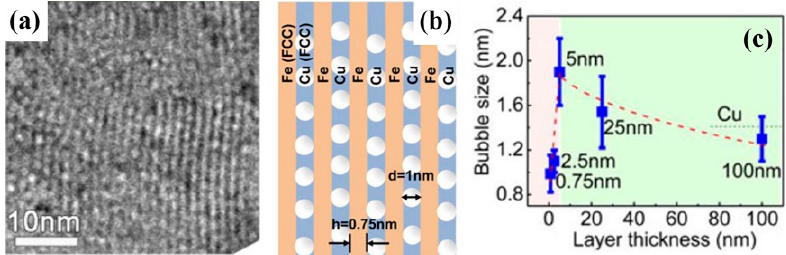
Figure 17. ( a ) TEM images of irradiated fully coherent 0.75 nm Cu / Fe multilayer. ( b ) Schematics illustrate that in a coherent 0.75 nm Cu / Fe multilayer, He bubbles prefer to nucleate in Cu layers and are constricted to reside inside Cu layers. ( c ) The variation of He bubble density with layer thickness h